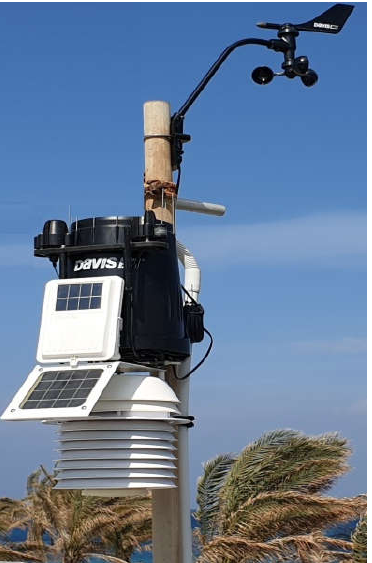
Figure 1. The meteorological station installed on a hotel rooftop in Crete, Greece.